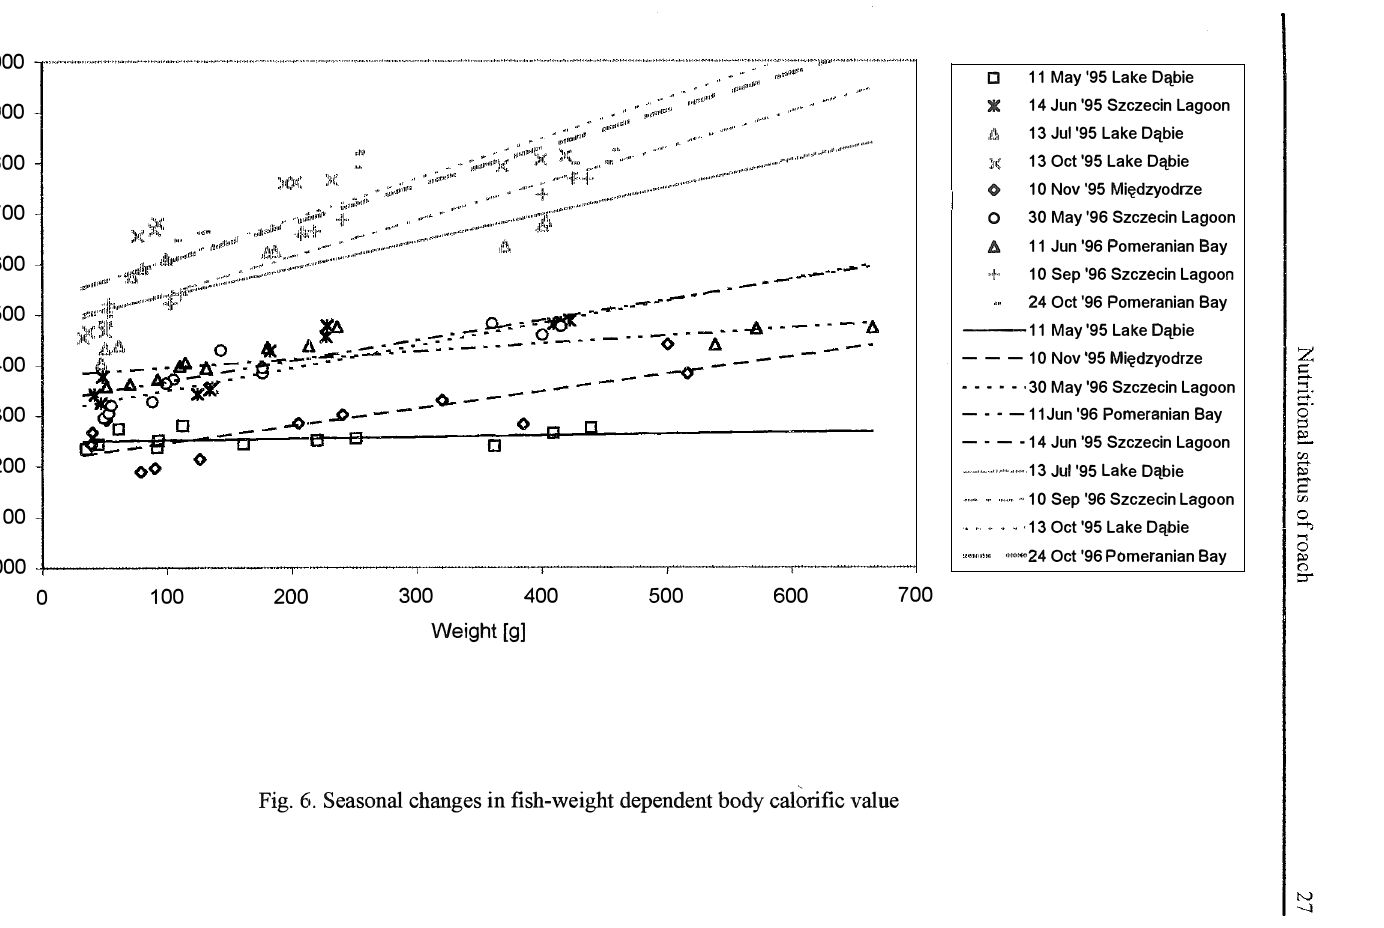
Fig. 6. Seasonal changes in fish-weight dependent body calorific